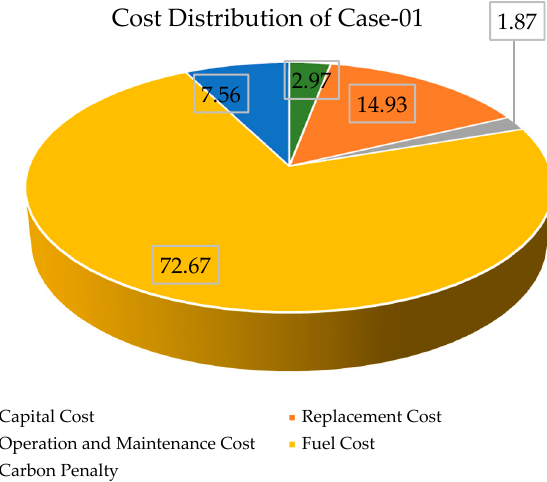
Figure 5. Convergence Plot (Case-01).